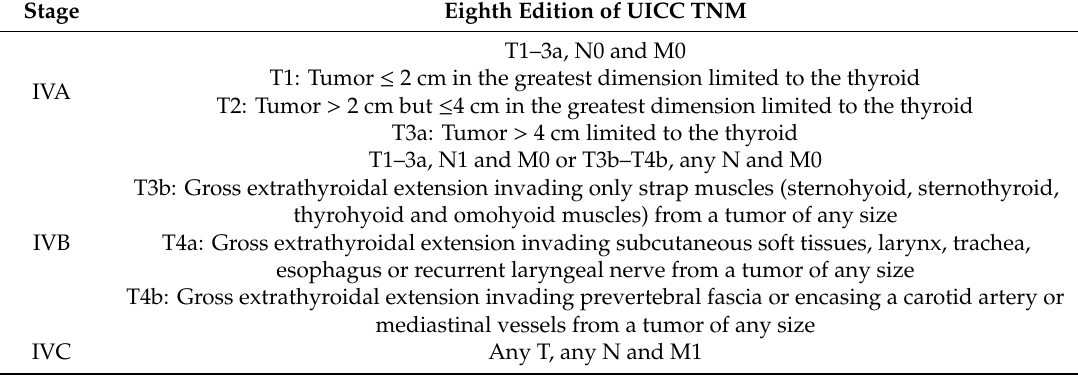
Table 4. Eighth edition of the Union for International Cancer Control Tumor–Node–Metastasis (UICC TNM)